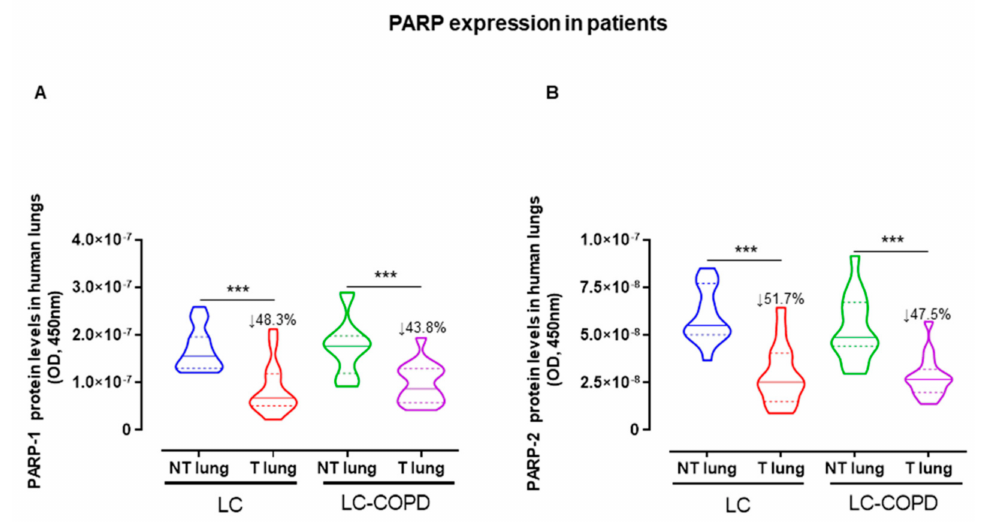
Figure 3. ( A , B ) Violin plots with median (continuous line) and interquartile ranges (discontinuous lines) of PARP-1 and PARP-2 protein levels assessed by ELISA in LC and LC-COPD patients, respectively. Statistical significance: *** p ≤ 0.001 between tumor (T) and non-tumor (NT) specimens in LC and